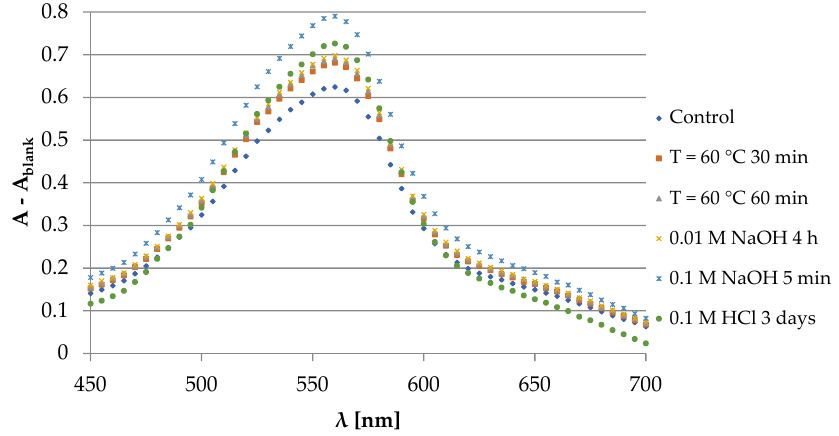
Figure A11. Absorption spectra of various Lf stress samples compared to Lf control sample (BCA method).